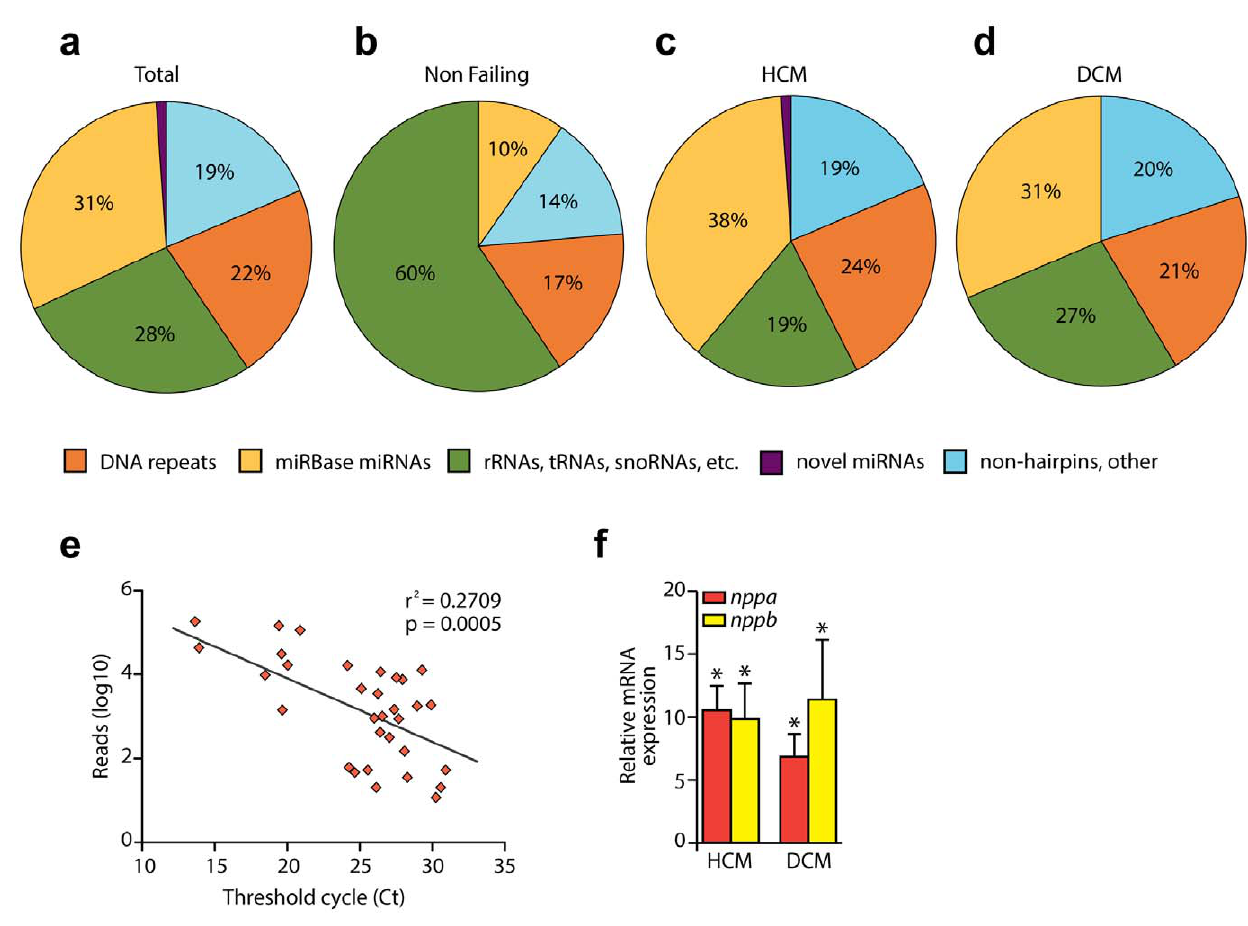
Figure 1. RNA content in the non-failing and failing human heart. A , Composition of global libraries, B , non-failing, C , hypertrophic cardiomyopathy (HCM), and D , dilated cardiomyopathy (DCM). E , Correlation of number of reads with cycle threshold (Ct) values obtained by real time quantitative PCR analysis of expression of 4 different microRNAs (miR-199a, miR-199b, miR-143 and miR-145). Data pairs are represented individually, independent of the miRNA analyzed. F . Real time quantitative PCR analysis of cardiac stress markers (nppa and nppb) in DCM and HCM samples.